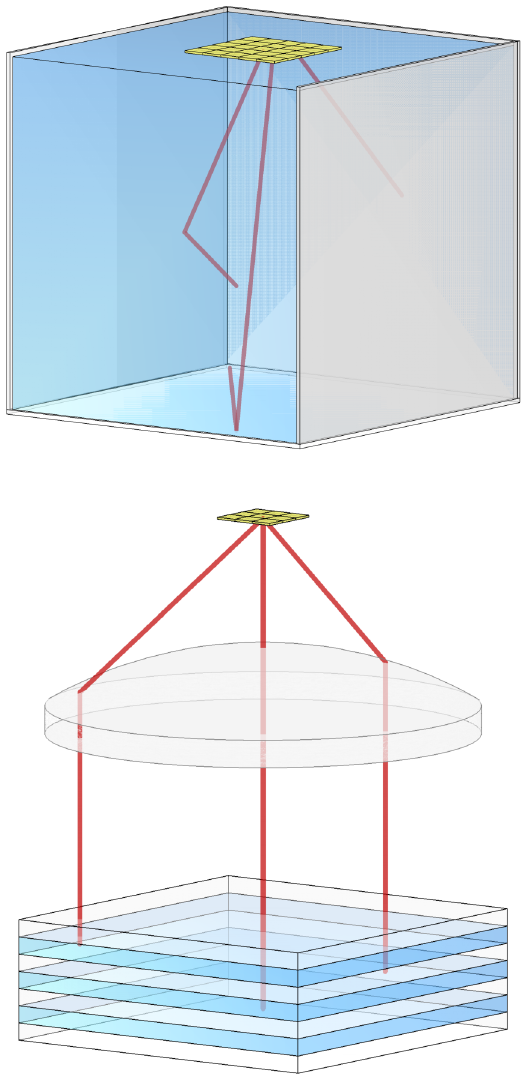
FIG. 4. Experimental setup: Bulk (top diagram) and stack (bottom diagram) configurations. Molecular gas (depicted by light blue volumes) is pumped into containers capable of supporting pressures up to 10 bar. In the bulk configuration, DM absorption events yield isotropic, single fluorescence photons, whose paths are indicated by thick red lines. Reflec- tive coatings (shown as silver colored sheets) lining the container boundary retain the signal photons until they impinge onto a large-area photodetector, displayed as yellow tiles at the top. The stack configuration features a pattern of alternating molecular density in the form of multiple slabs. This container geometry and the spatial coherence of DM can produce cooperatively emitted photons nearly perpendicular to the slabs, making it possible to focus them onto a tiny photodetector by a lens. The photon direction is sensitive to the DM velocity vector projected onto the plane defined by the slabs. For illustrative purposes, we do not show shielding, cooling, or electromag- netic field and pressure control systems in either setup. We also left out the reflective coatings on the front and top faces of the bulk